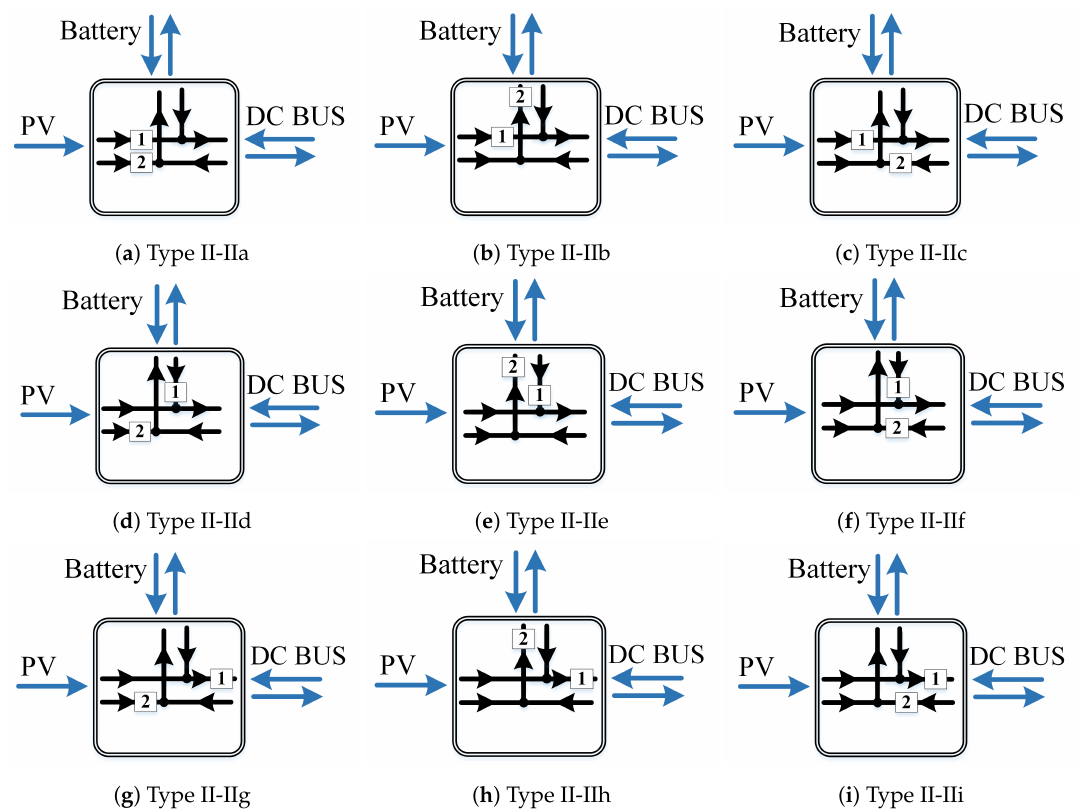
Figure 6. All possible configurations of 2 of Type II-II using unidirectional SISO